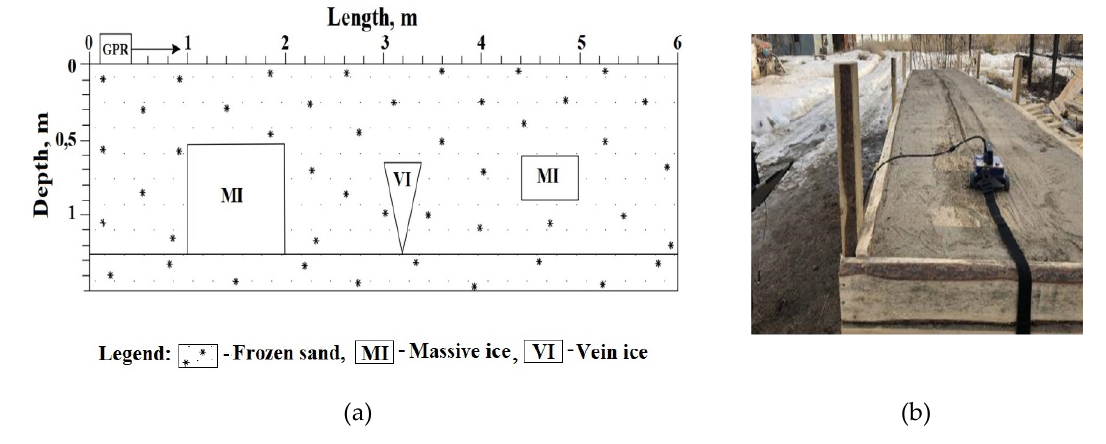
Figure 4. The scheme of the rock mass with the inclusion of ice ( a ) and a photograph of the process of the GPR measurements by the OKO-2 GPR ( b ).